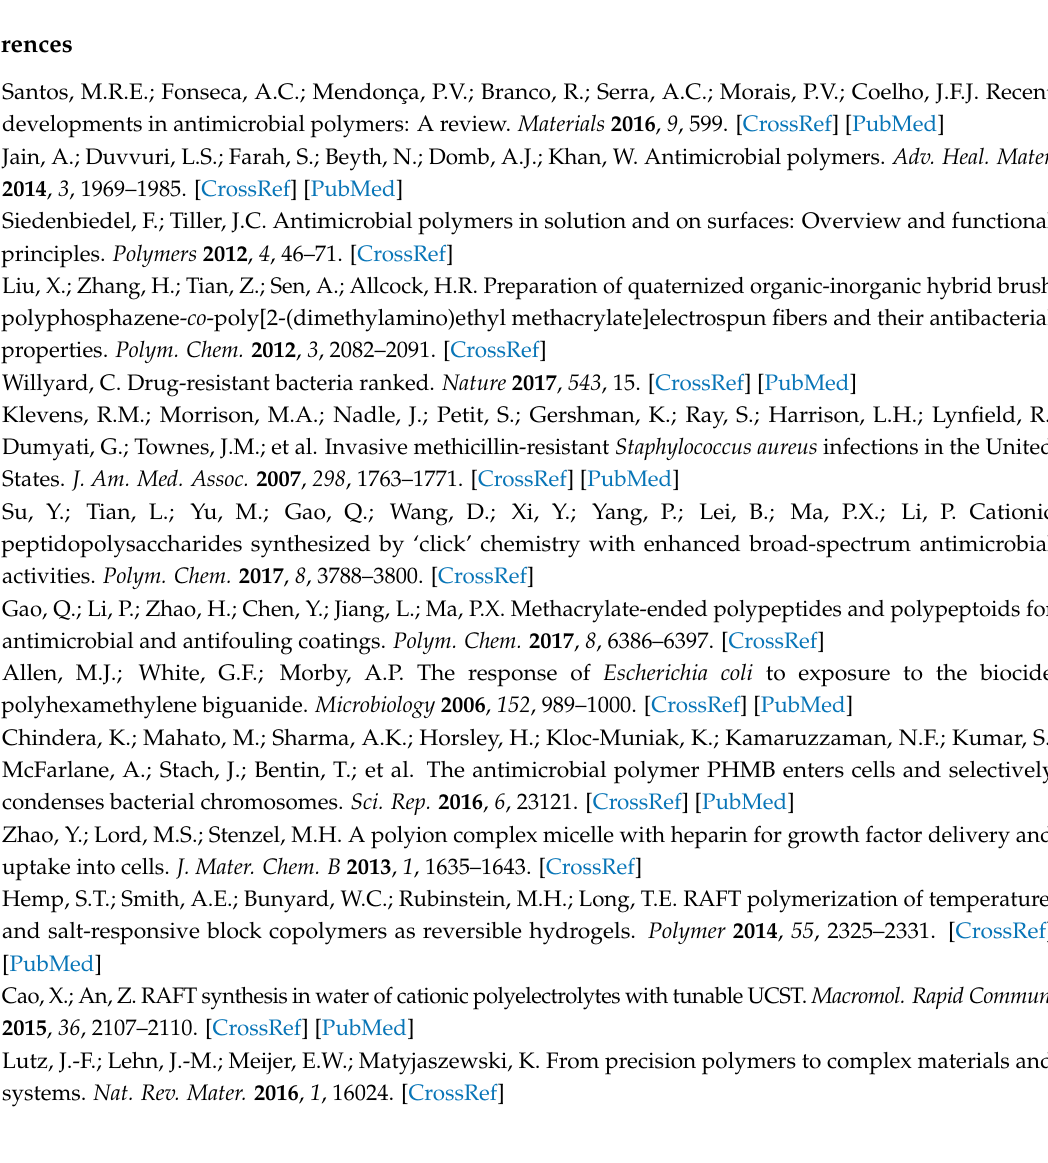
Figure S1: Transmittance measurement of the suspensions of poly(METAC)-gel with B. subtilis